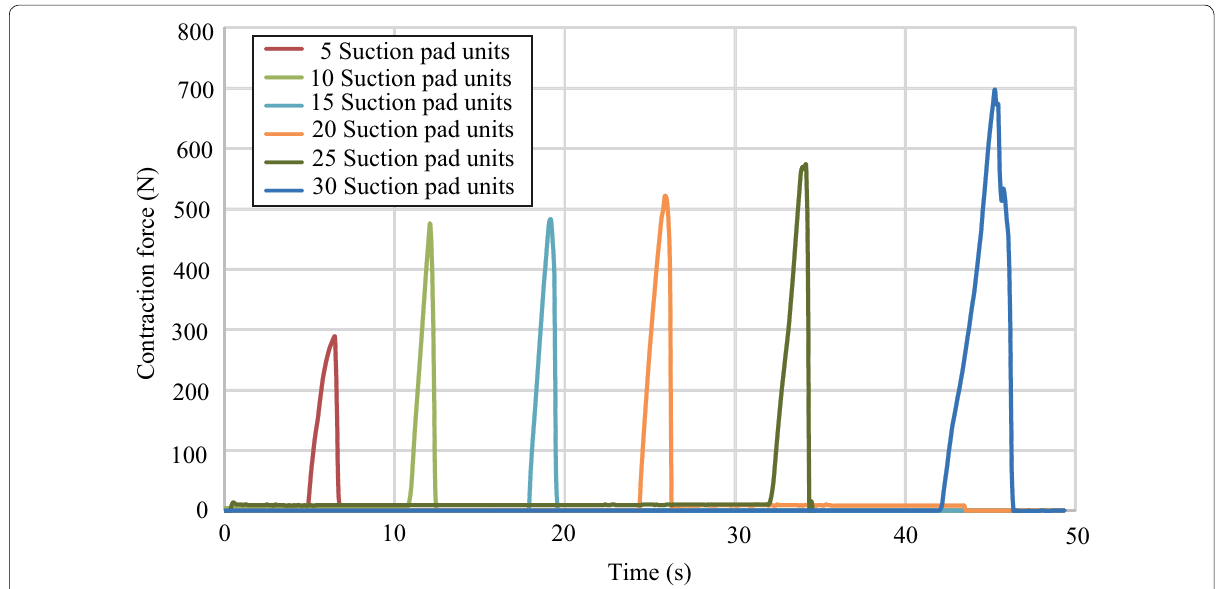
Fig. 43 Experimental results for evaluation of contraction force by the end effector alone